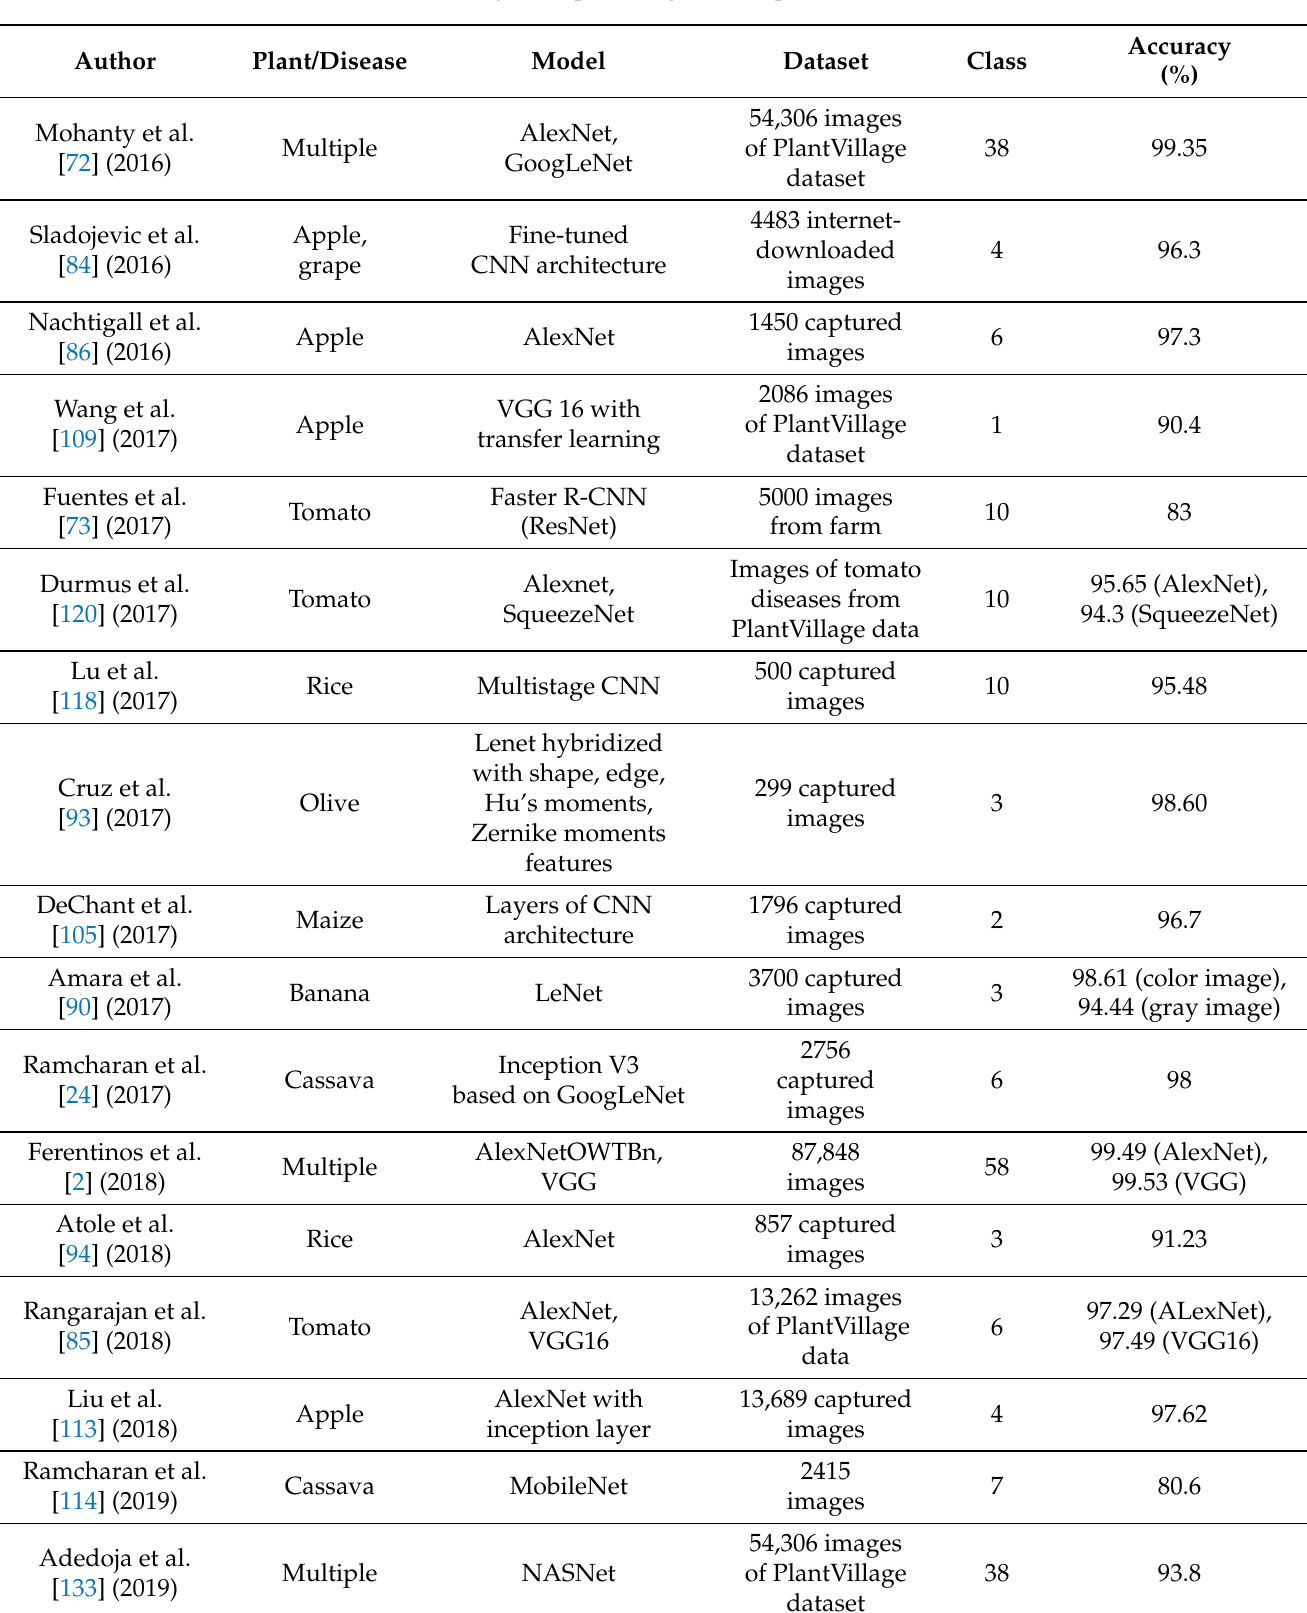
Table 5. Summary of deep-learning-based implemented